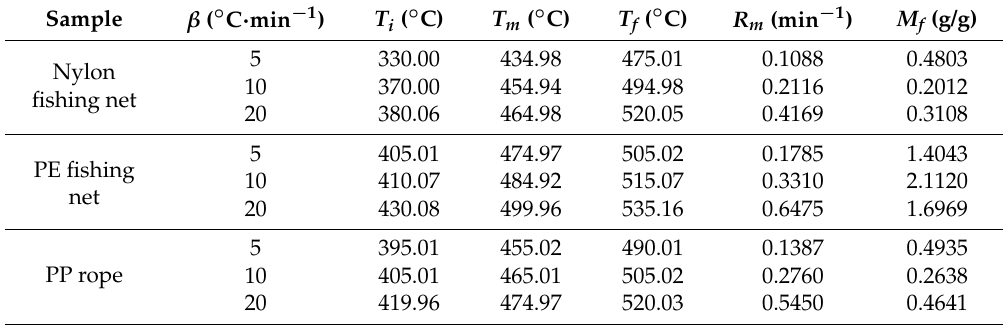
Table 2. Characteristics of the plastic coastal debris samples in the pyrolysis